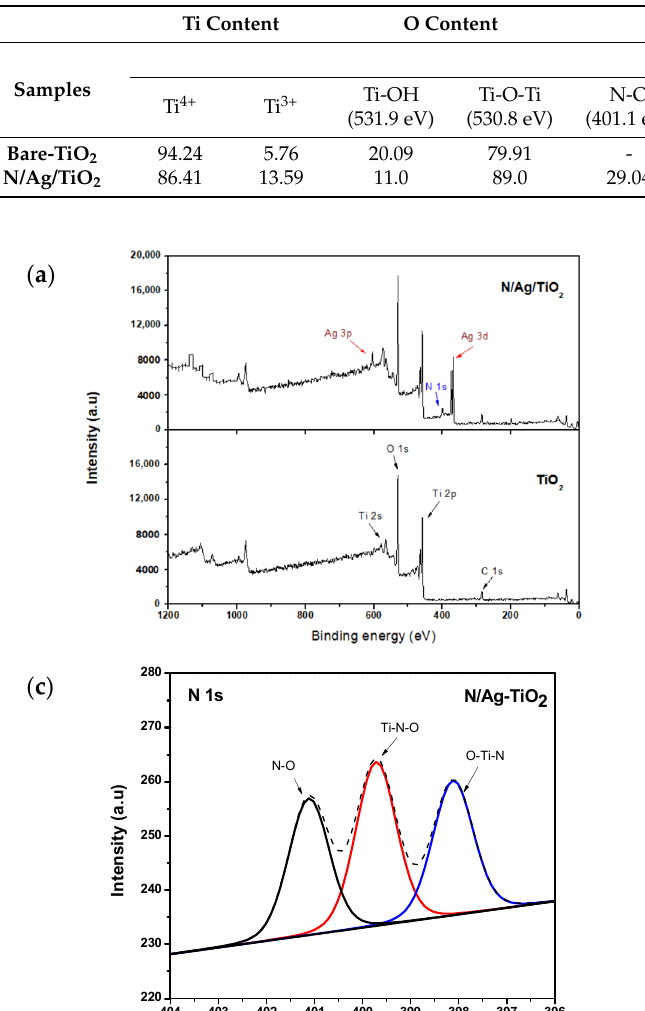
Table 3. Surface compositions (in at. %) of bare-TiO 2 and N/Ag/TiO 2 photocatalysts, obtained by XPS.